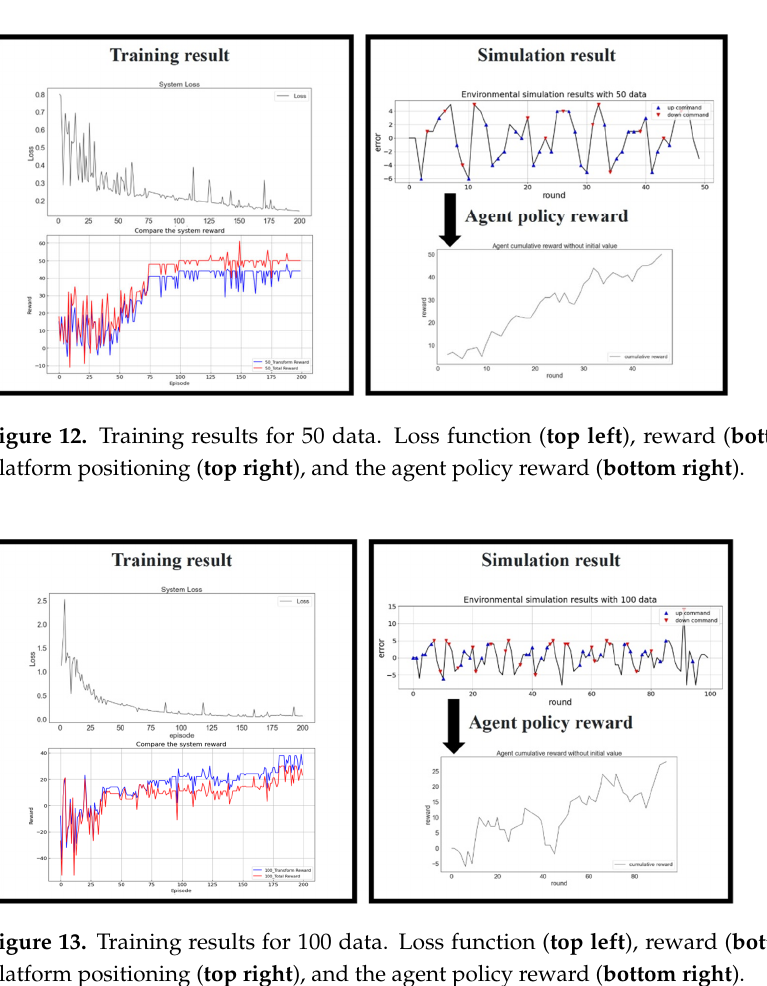
Figure 13. Training results for 100 data. Loss function ( top left ), reward ( bottom left ), simulated platform positioning ( top right ), and the agent policy reward ( bottom right ).